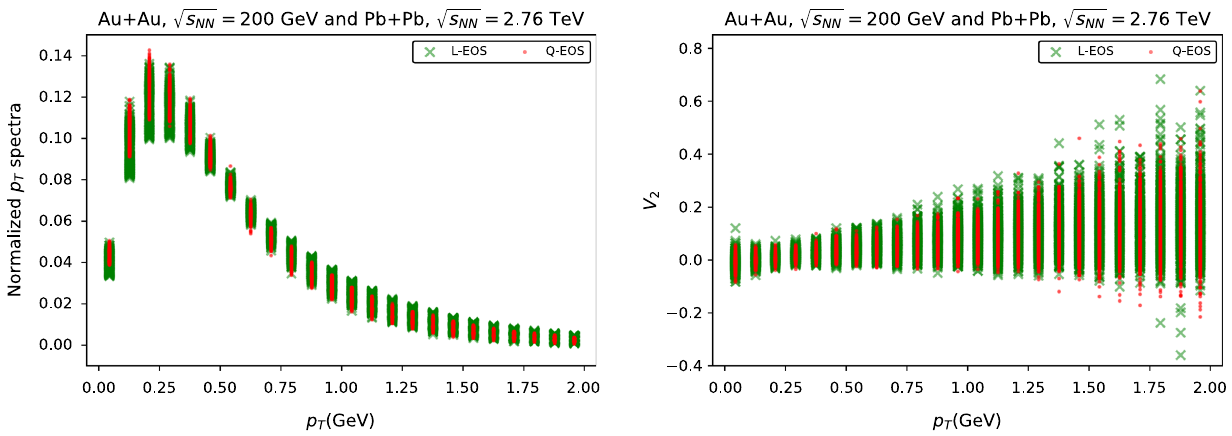
Fig. 7 Same as Fig. 6 but for 30-events-fine-averaged normalized p T spectra d N / N d y d p T (left panel) and elliptic flow v 2 as a function of p T (right